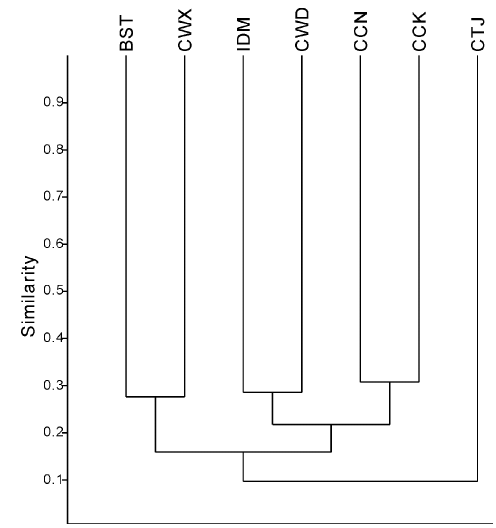
Fig. 3. Cluster analysis (CA) of six representatives of the Saucrorthis Fauna in the South China palaeoplate (4), Sibumasu palaeoplate (1) and peri-Gondwana terrane (northern Iran) (1) with the contemporaneous association from the Lower Formation of the Chiatsun Group of southern Tibet as an outgroup, showing the strong endemism and provincialism during late Middle Ordovician